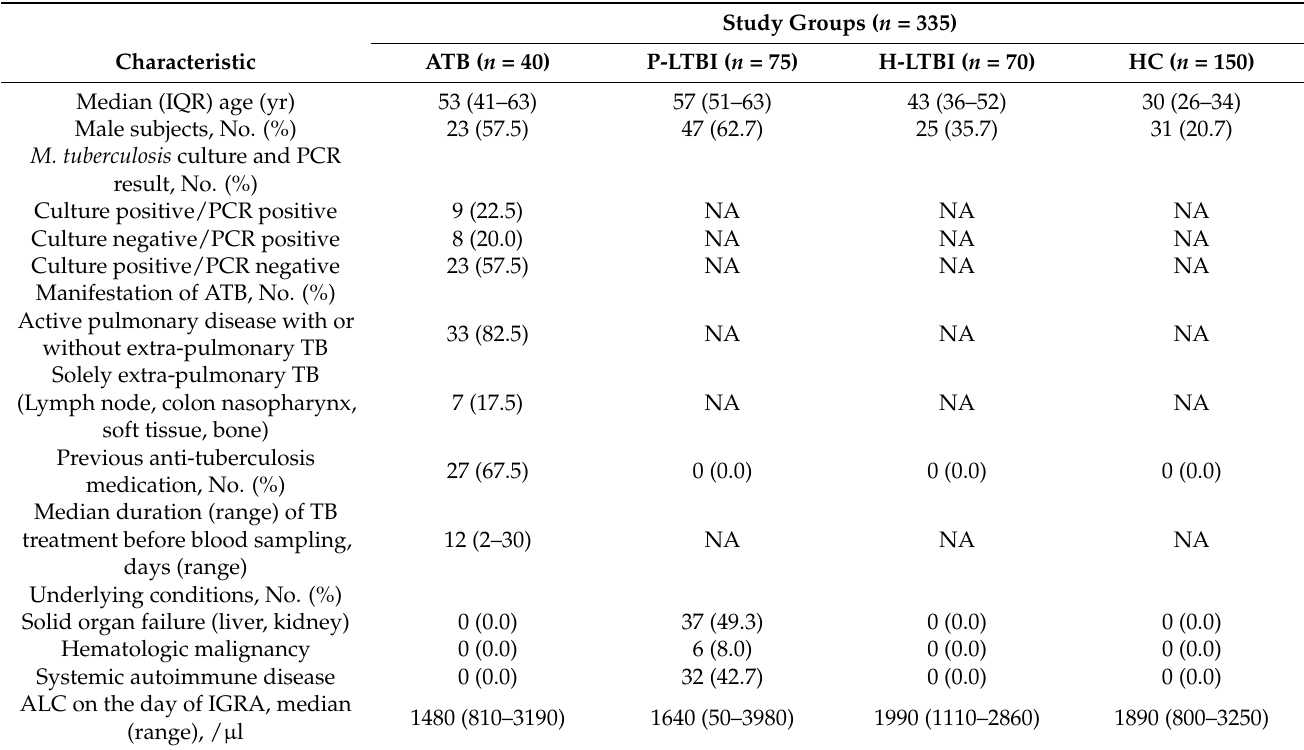
Table 1. Characteristics of study